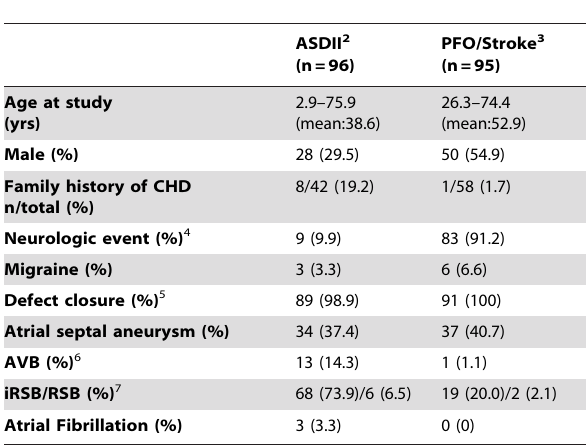
Table 4. Clinical characteristics 1 of German cohort. Table 5. GATA4 genotypes of German cohort.